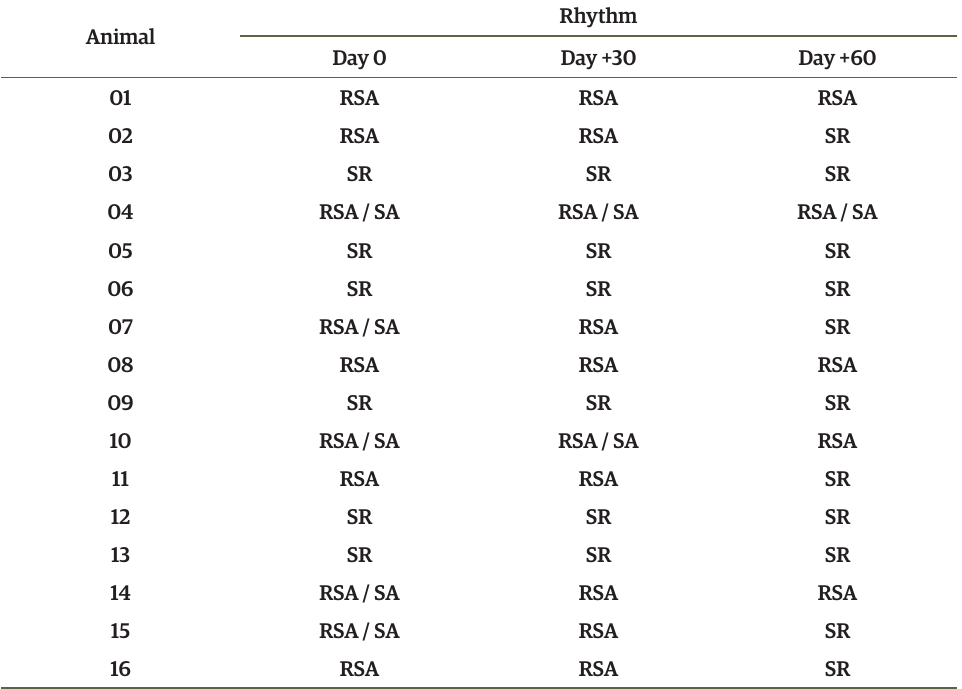
Table 5. Electrocardiographic findings of the patients’ heart rate before (day 0) and after the rhinoplasty procedure (days +30 and +60).